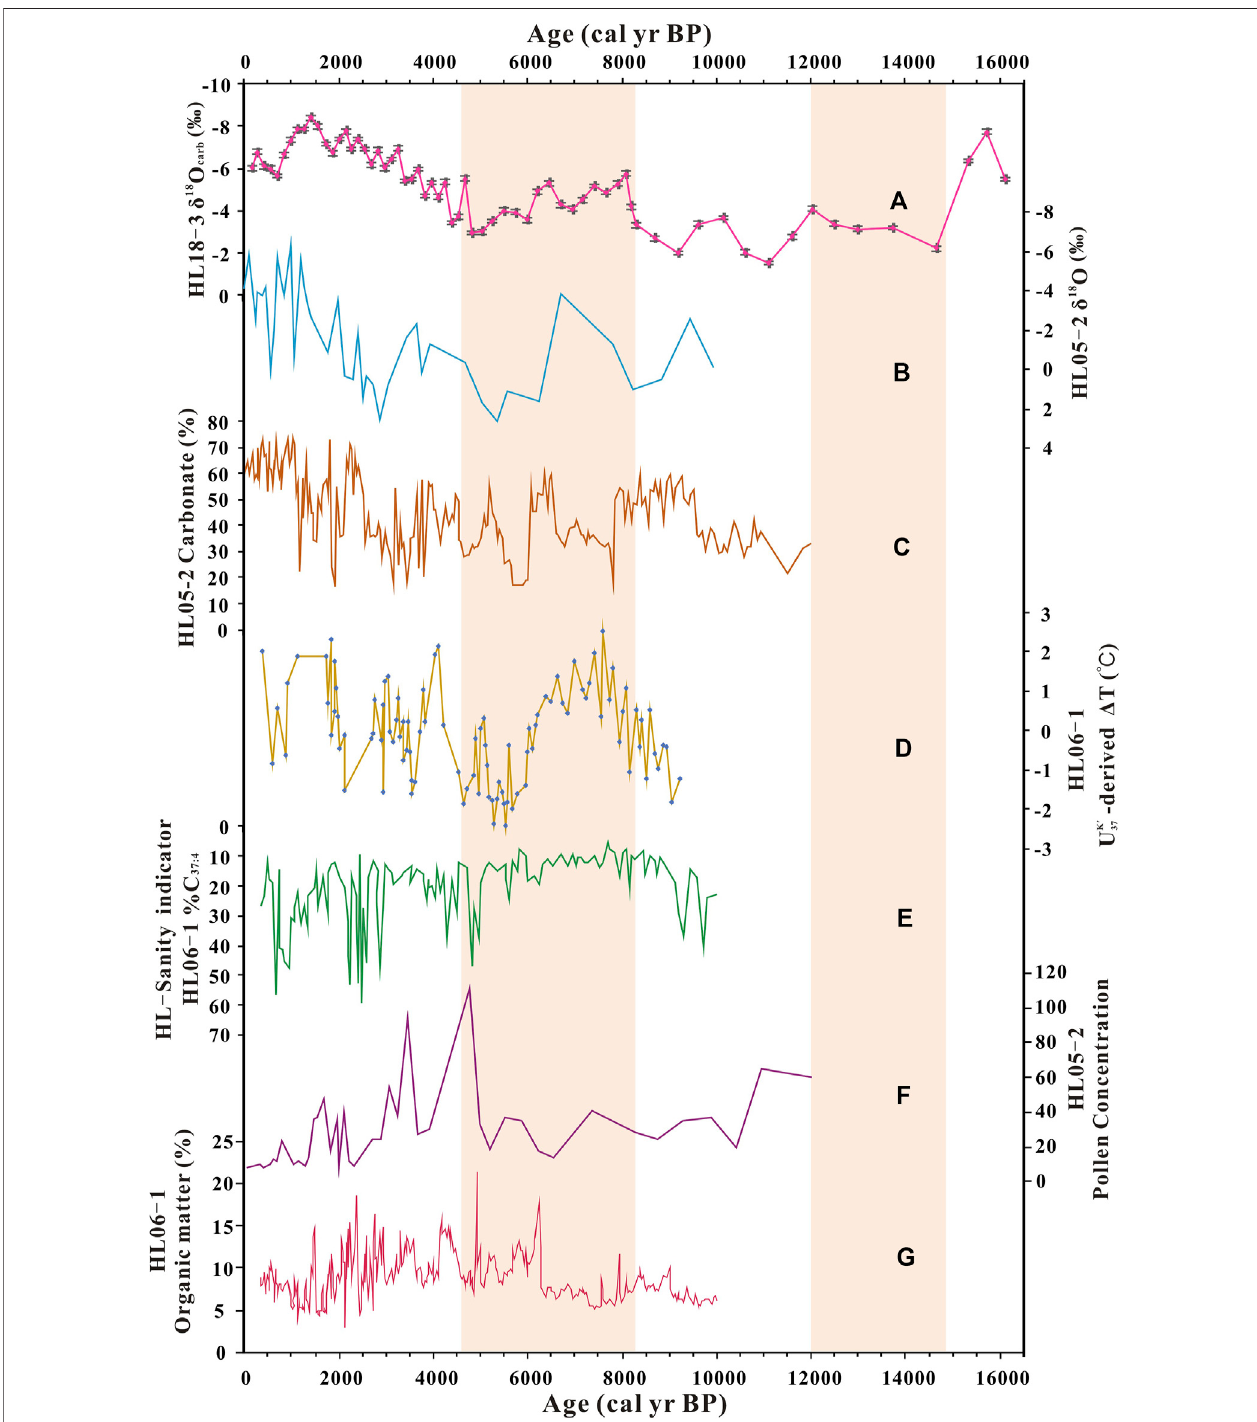
FIGURE 6 | Multiple geochemistry-proxy records derived from Hurleg Lake. (A) The δ 18 O carb in the HL18-3 core. (B) The δ 18 O carb in the HL05-2 core (Zhao et al., 2010). (C) Thecarbonatepercentage(%)oftheHL05-2(Zhaoetal.,2010). (D) U K ’ 37 -derivedtemperaturerecord( Δ T)fromtheHL06-1core(Zhaoetal.,2013). (E) Salinity indicator of alkenone-based %C 37:4 derived from HL06-1 (He et al., 2016). (F) Pollen concentration from HL05-2 (Zhao et al., 2007; Zhao et al., 2013, with updated chronology). (G) Organic matter percentage (%) of HL06-1 (Zhao et al., 2010).